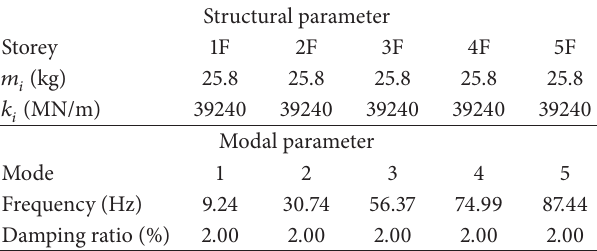
Table 1: Parameters of a five-storey shear